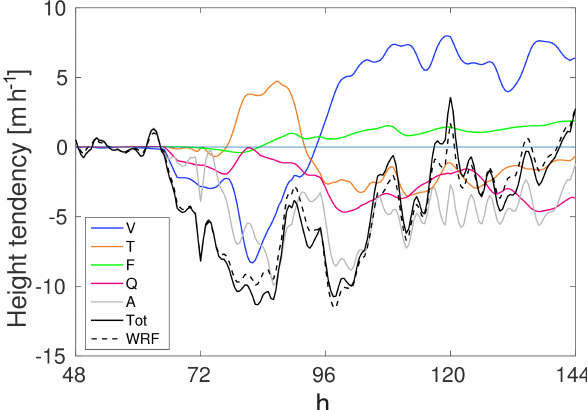
Figure 9. Time series of individual height tendency components at the 900hPa level from the cyclone centre during the deepening pe- riod. V is vorticity advection, T is thermal advection, F is friction, Q is diabatic heating, A is imbalance term, Tot is total and WRF is WRF height tendency. Height tendencies at the cyclone centre were averaged over all grid boxes in which the 900hPa geopoten- tial height was less than 5m above its minimum. In addition, the values are 2.5h moving